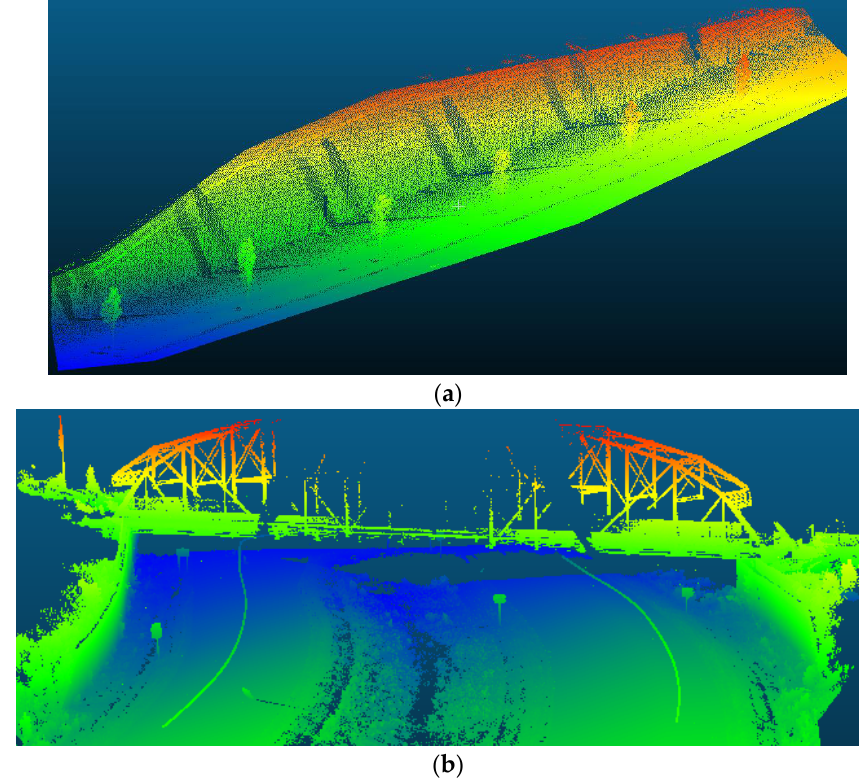
Figure 8. MSE wall point clouds collected by the MLS at ( a ) Site-1 and at ( b ) Site-2.